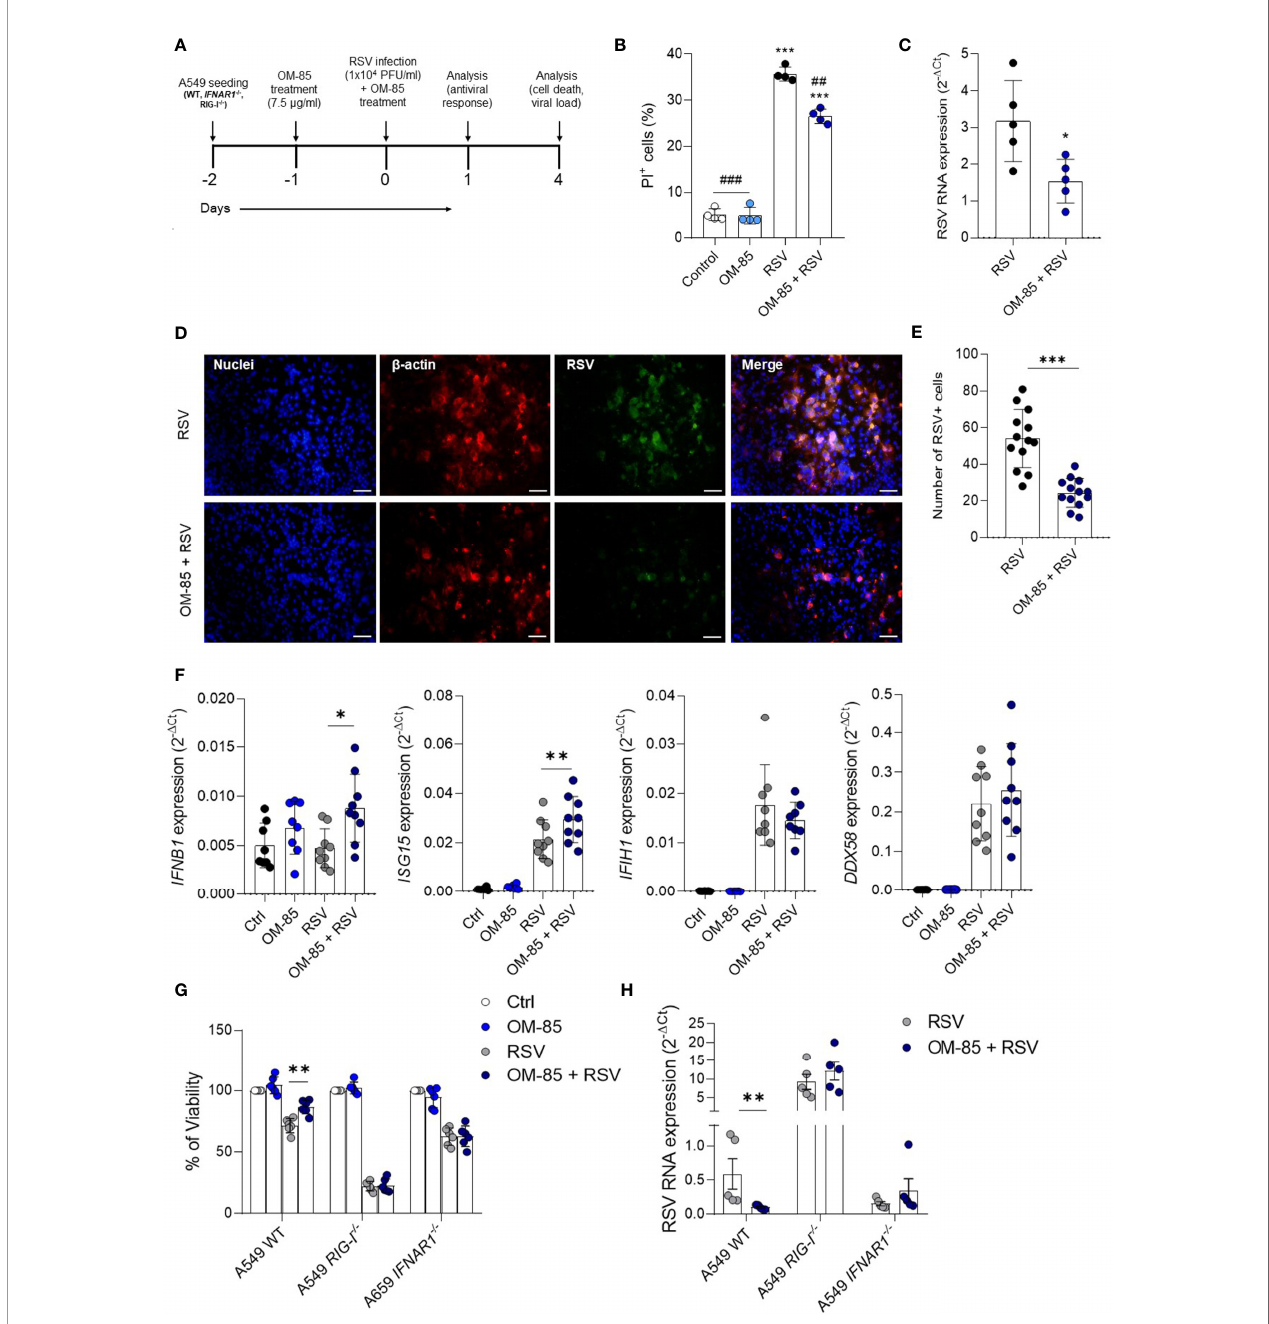
FIGURE 8 | Pretreatment with OM – 85 protects against RSV infection in vitro depending on type I interferon pathway. Mycoplasma – free A549 cells (8 x 10 4 cells/ml) were treated with OM – 85 (7.5 ug) for 24hs. Afterward cells were washed and placed fresh new media and then infected with RSV (10 4 PFU/ml) and received a boost of OM – 85 treatment. The culture was left for 1 [as in (F) or 4 days (as in (B – D, E, G, H) ]. (A) Experimental design. (B) Percent of PI (propidium iodide) positive cells detected by fl ow cytometry. (C) RSV RNA levels detected using real – time PCR (2 – D Ct ). (D) Immuno fl uorescence images showing staining of cell nuclei (Hoescht – blue), B – actin (red) and RSV (green). Scale bars=0.5 m m. (E) Number of RSV+ cells measured in the immuno fl uorescence images. (F) IFNB1 , ISG15 , IFIH1 (MDA5), and DDX58 (RIG – I) gene expression detected by real – time PCR. (G, H) A549 WT, A549 IFNAR1 – / – , and A549 RIG – I – / – cells (8 x 10 4 cells/ml) were treated with OM – 85 (7.5 ug) for 24hs. Afterward cells were washed and placed fresh new media and then infected with RSV (10 4 PFU/ml) and received a boost of OM – 85 treatment. The culture was left for 4 days until analysis. (G) Cell viability assessed by MTT assay using untreated/uninfected control as 100% of viability. (H) RSV RNA levels detected using real – time PCR (2 – D Ct ). All data are expressed as mean±SEM. Multiple groups were compared using Kruskal – Wallis, except in (C, E) in which the comparison between groups was made using Mann – Whitney test. # indicates the statistical difference compared to RSV. ## p < 0.01, ### p < 0.001. * p <0.05. ** p <0.01, *** p